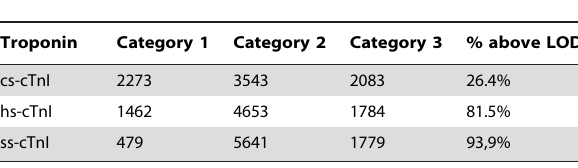
Table 2. Absolute and Relative Distributions of Troponin I Concentrations in the Study